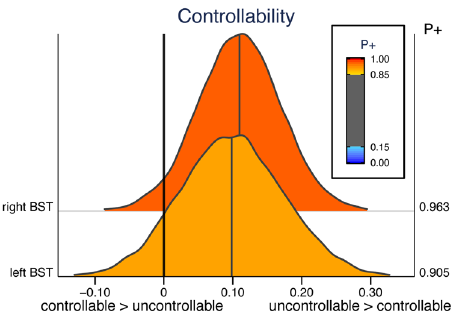
Fig. 5 Trial-by-trial brain – skin conductance correlation and controllability. Posterior distributions are shown for the left BST right BST. P + indicates the probability that uncontrollable is great